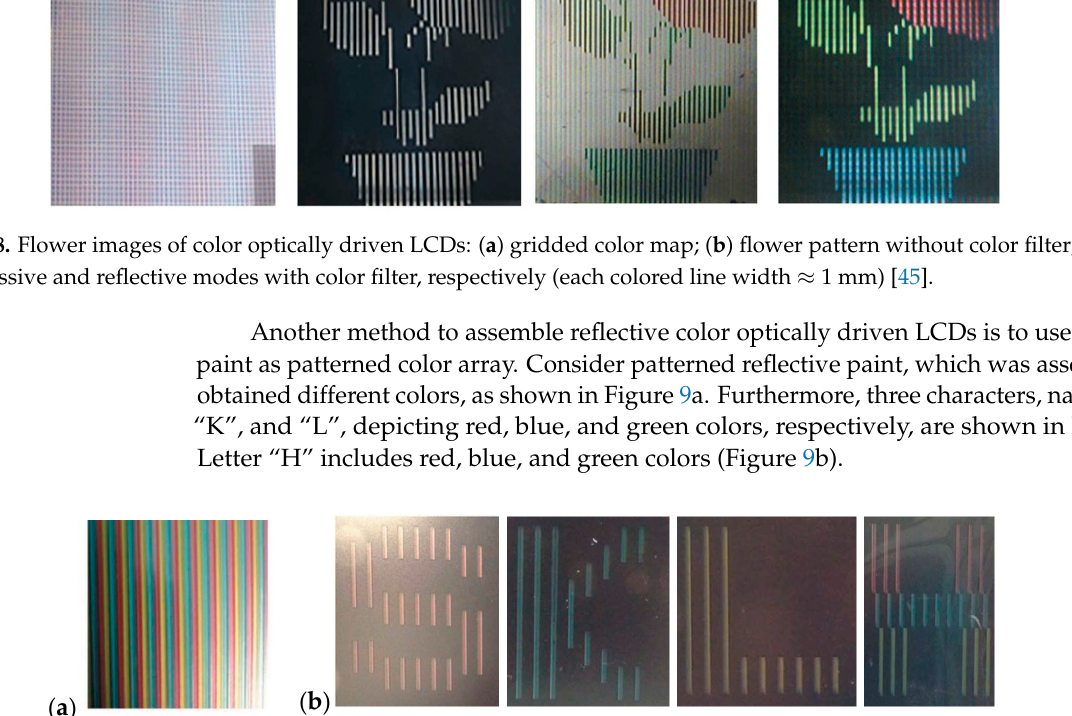
Figure 9. ( a ) Patterned colors: each color line ≈ 1 mm. ( b ) Colored images of letters, obtained by using reflective paint [45].